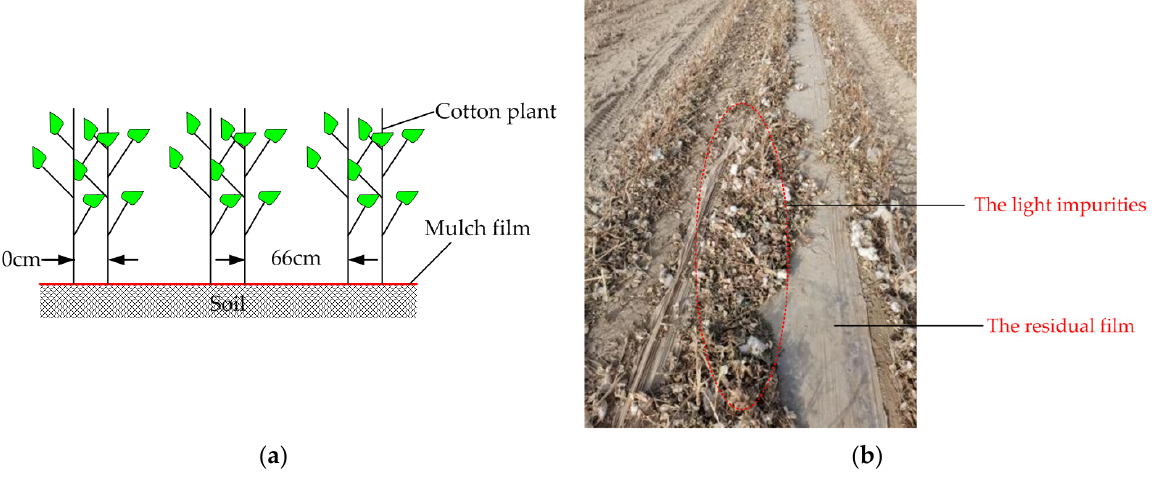
Figure 11. Cultivation mode and operating conditions before test. ( a ) Cultivation mode. ( b ) Oper- ating conditions before test. conditions before